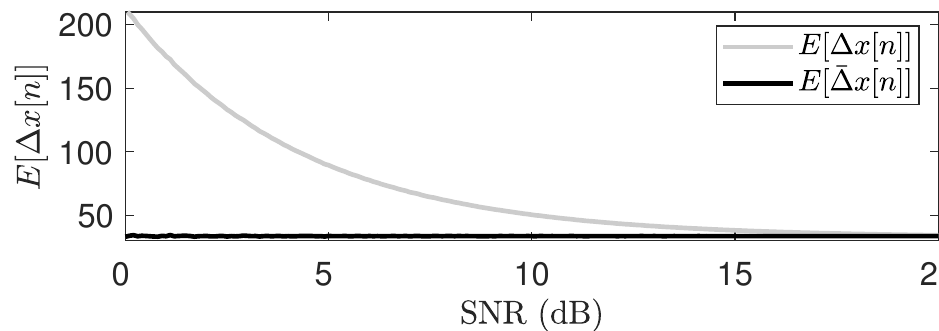
Figure 2. Feature variation based on SNR. Gray line represents difference power; black line represents the proposed unbiased difference power.